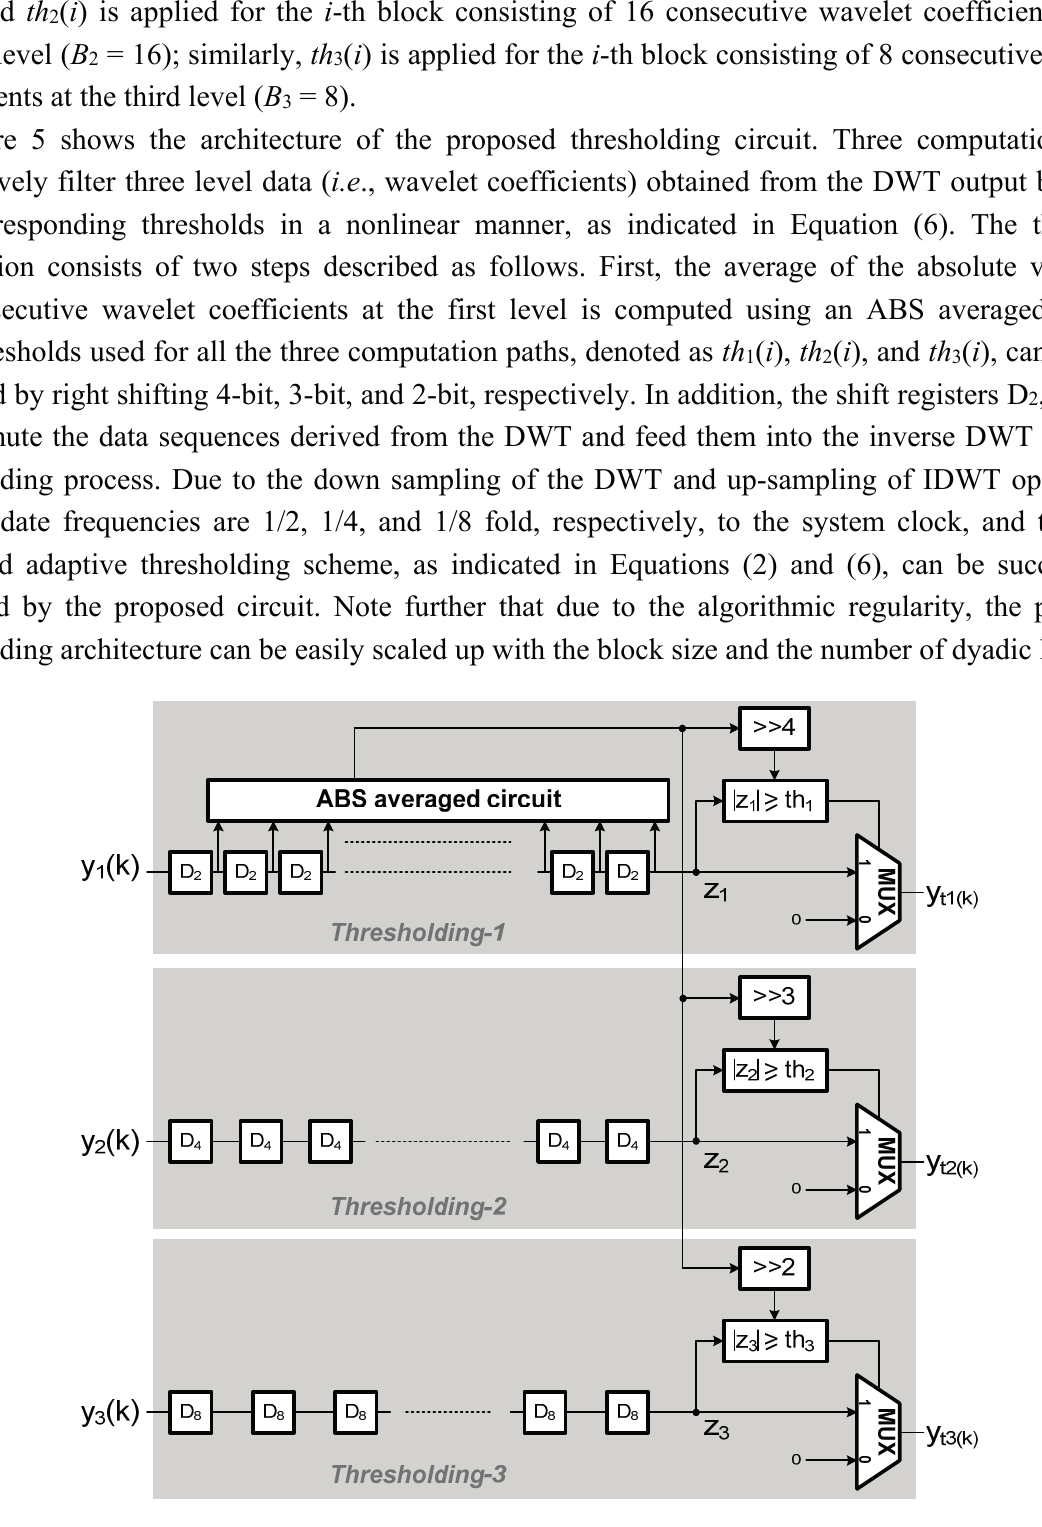
Figure 5. The architecture of the proposed thresholding